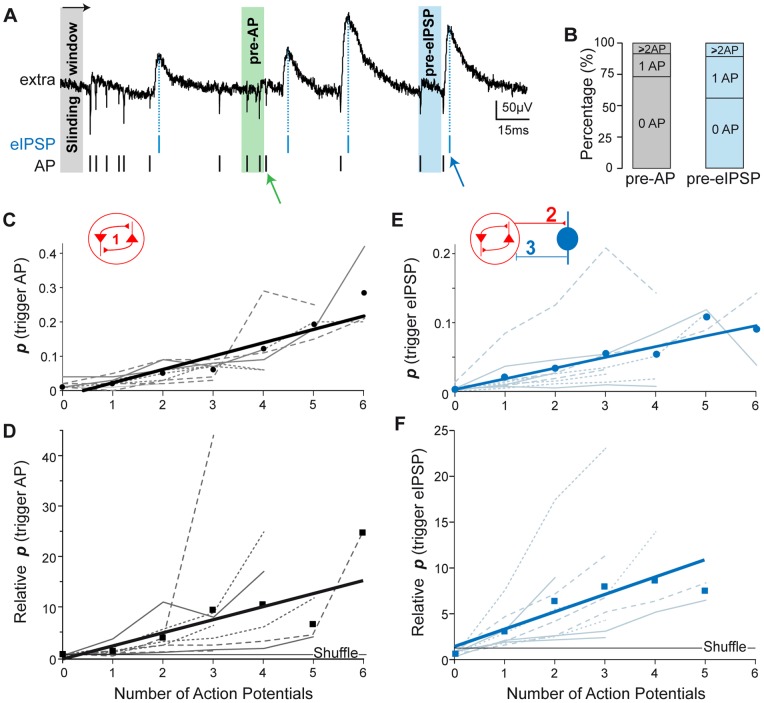
Recruitment of neuronal firing and inhibition in the CA3 circuit.A. The number of action potentials (AP, vertical bars and green arrow) within a 10 ms sliding window (time step 1 ms) was used to quantify the probability (see methods) for spike discharge to trigger action potentials (Pre-AP, light grey) or eIPSPs (Pre-eIPSP, light blue). Vertical blue line and arrow, eIPSP peak. B. Vertical bars show the probability (averaged from 9 animals) that an AP (left, grey) or eIPSP (right, blue) was preceded by a given number of spikes (within 10 ms). Note that only few (<10%) events (AP or eIPSPs) were preceded by more than 1 spike. C–F. Graphs showing the probability (absolute and relative to chance, see methods) that a given number of spikes (X axis) triggered a spike (C, D) or an eIPSP (E, F). Broken lines, individual animals (dotted lines, mice; dashed lines, guinea pigs rats; plain lines, rats); dots/squares, average values; thick lines, linear fit (see Table 1 for corresponding R2 and p values). Note the increasing probability of recruitment relative to chance (D, F), suggestive of neuronal cooperation in the circuit, and the modest absolute probabilities (<12% for eIPSP recruitment), suggestive of globally low levels of recruitment in the circuit.